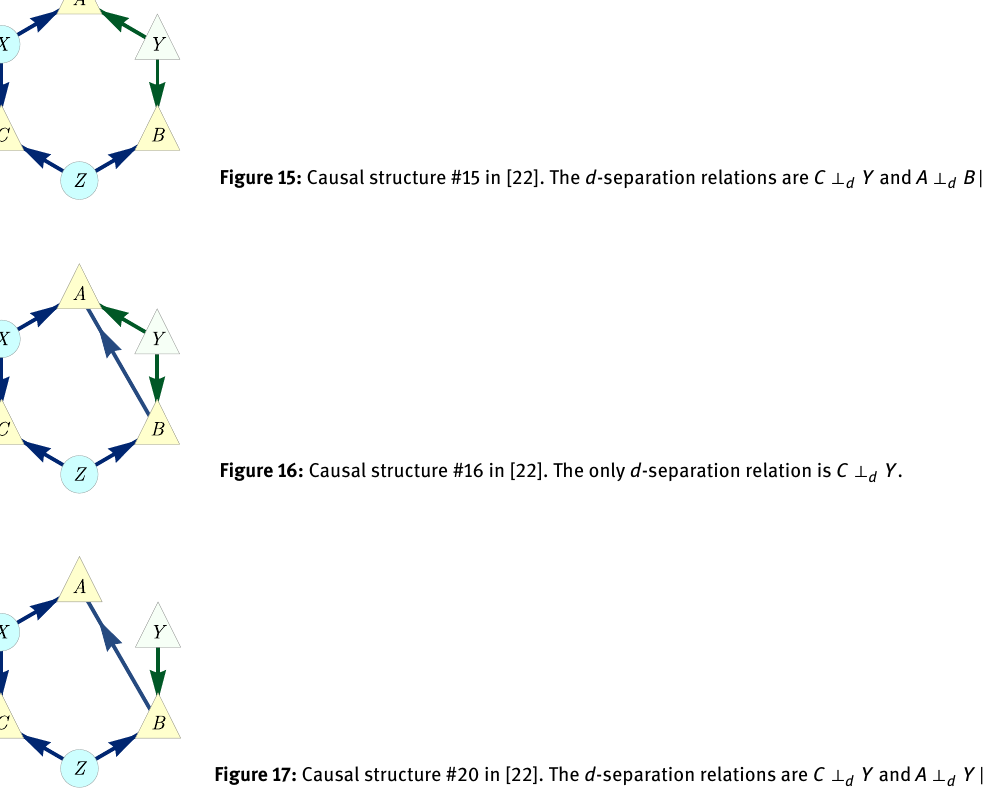
Figure 15: Causal structure #15 in [22]. The d -separation relations are C ⊥ d Y and A ⊥ d B | Y .